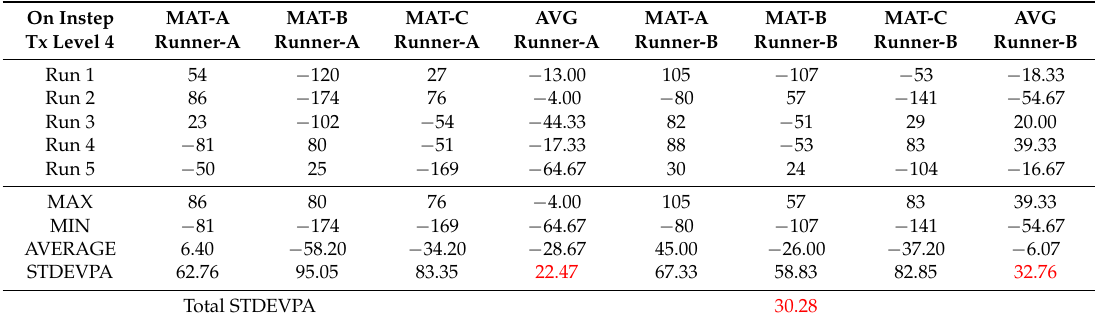
Table 15. The experiment in which two runners with a BLE Tag on their respective insteps ran through three sets of